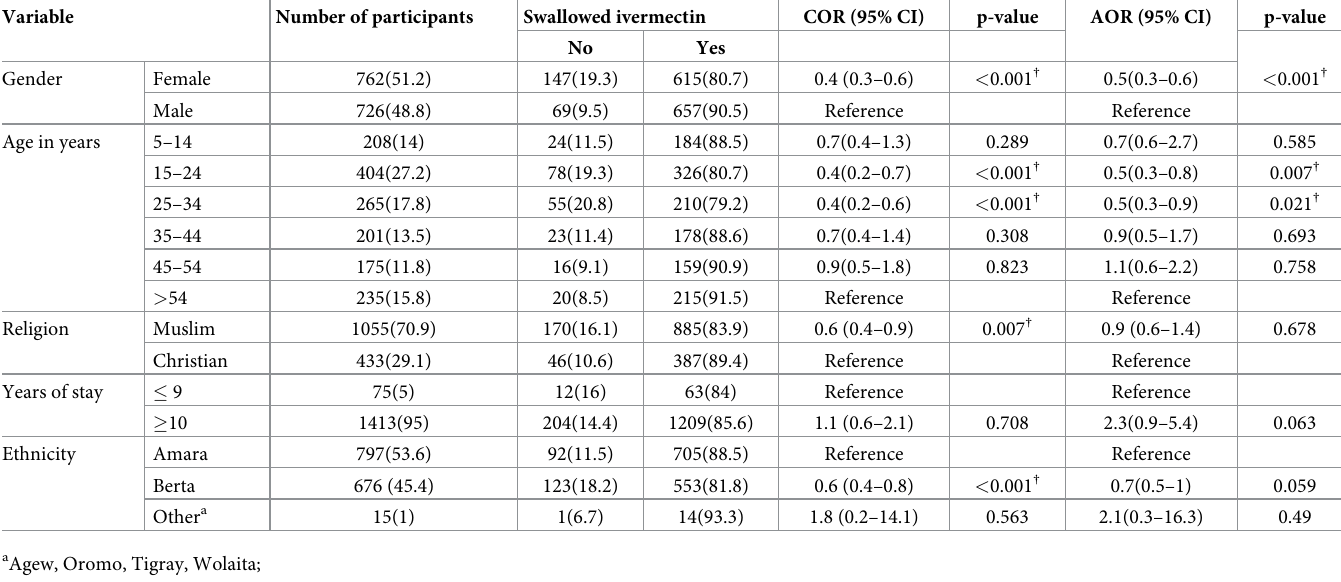
Table 3. Results of the regression analysis in the MDA coverage in Asosa district.